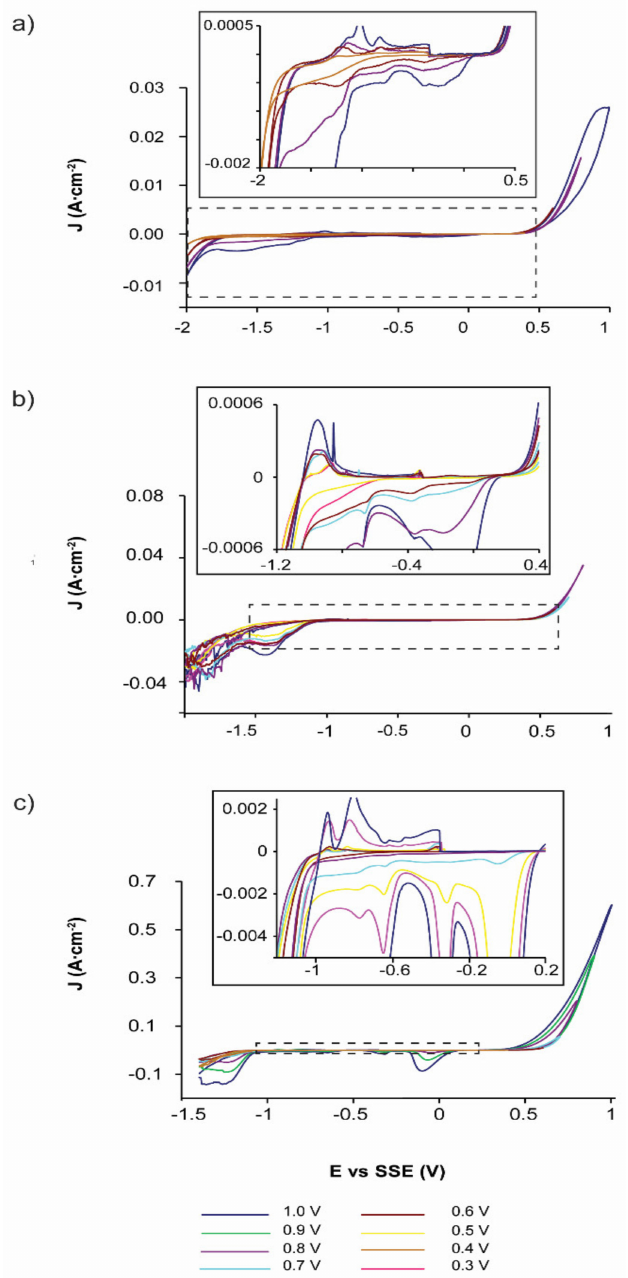
Figure 4. Typical CPE-ZnS voltamperograms (70:30 wt.%) obtained at a scan speed of 100 mVs − 1 . The scan was initiated in the positive direction. ( a ) 04.1 M Na 2 SO 4 , pH = 7; ( b ) 0.1 M H 2 SO 4 , pH = 2; ( c ) 1.7 M H 2 SO 4 . The colors indicated different values of inversion anodic potential. Full line squares showed the detailed redox processes indicated in dashed